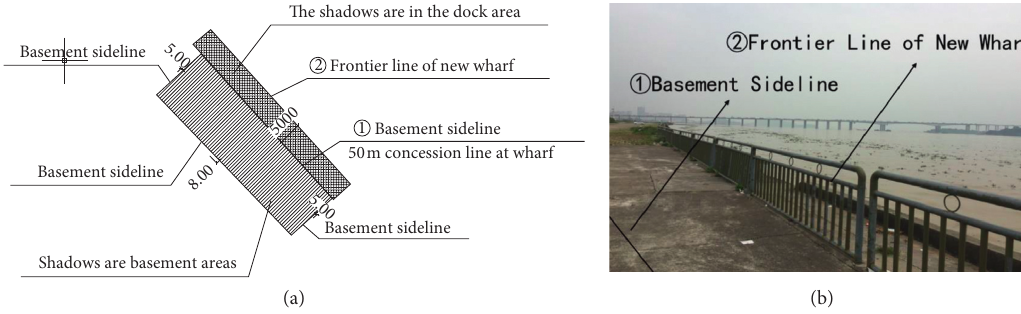
Figure 2: Renovation plan of the wharf. (a) Layout plan. (b) Corresponding location on-site.